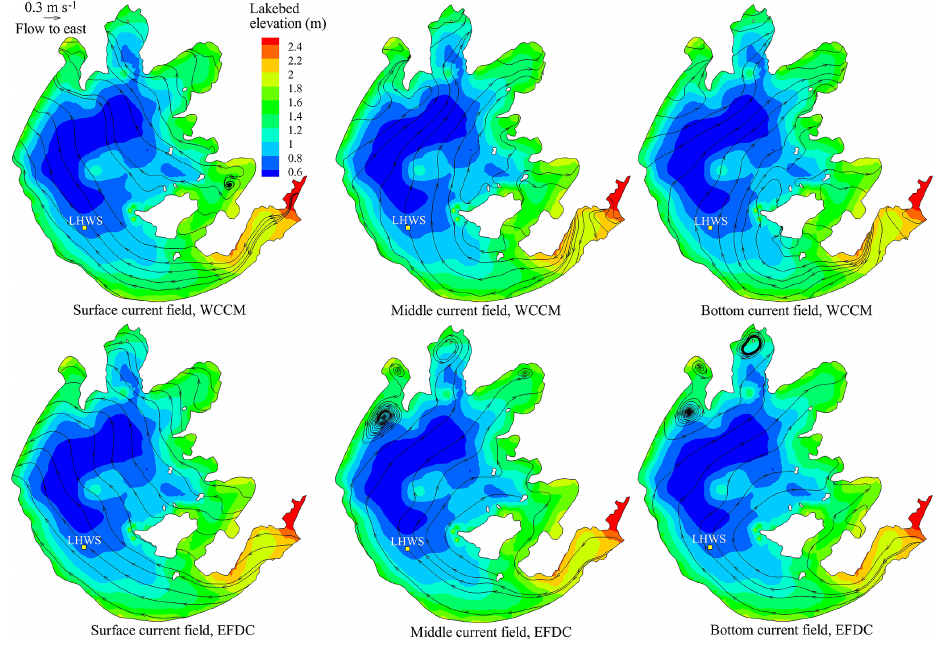
Figure B3. Comparison of the flow fields and stream traces in the surface, middle, and bottom layers of Lake Taihu simulated by the WCCM and EFDC at 12:00LT on 10 August 2015.